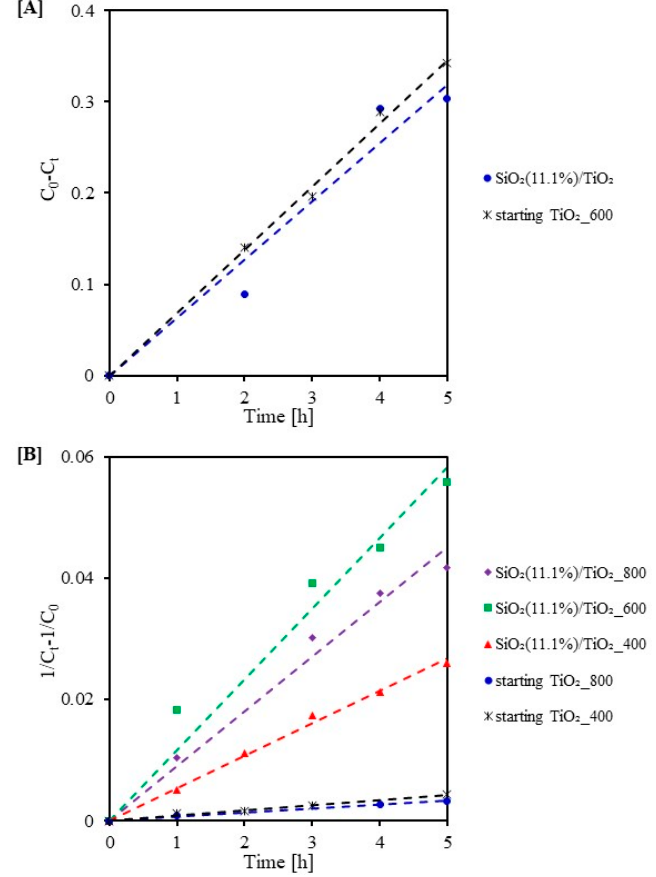
Figure 10. The zero-order plot ( A ) and the pseudo-second-order plot ( B ) of methylene blue decomposition during 5 h of irradiation under VIS. Process conditions: C MB = 10 mg/L, V s = 0.5 L, C photocat. = 0.2 g/L, adsorption time—1 h. Table 4. The fitting parameters, zero, pseudo-first, and pseudo-second reaction rate constants for methylene blue decomposition (after 5 h of UV-VIS radiation).